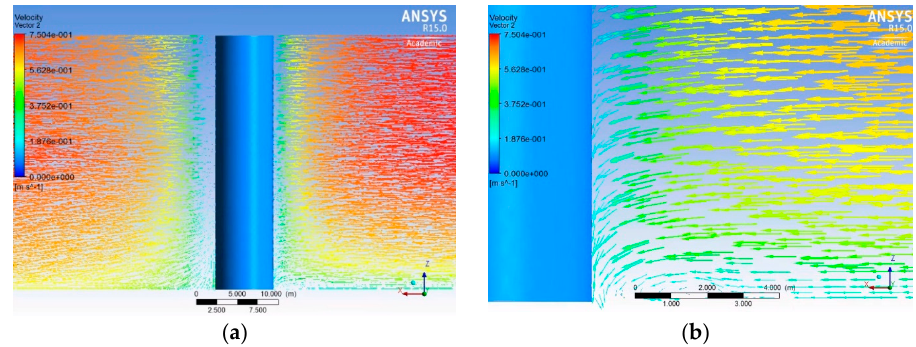
Figure 8. Velocity vectors on the symmetric plane xz before using the SEMCD: ( a ) plane view; ( b ) details of the flow in front of the monopile.